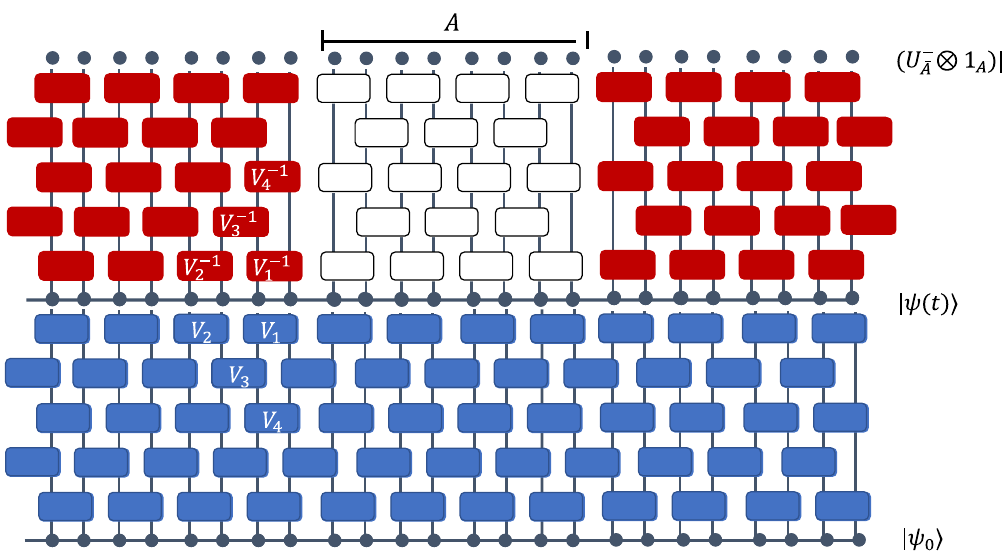
FIG. 17. Blue rectangles indicate the local unitaries of the original circuit, red rectangles indicate their inverses used to construct U − , and white rectangles indicate the identity operator. We show the action of U − ¯ unitaries in the definition of U −